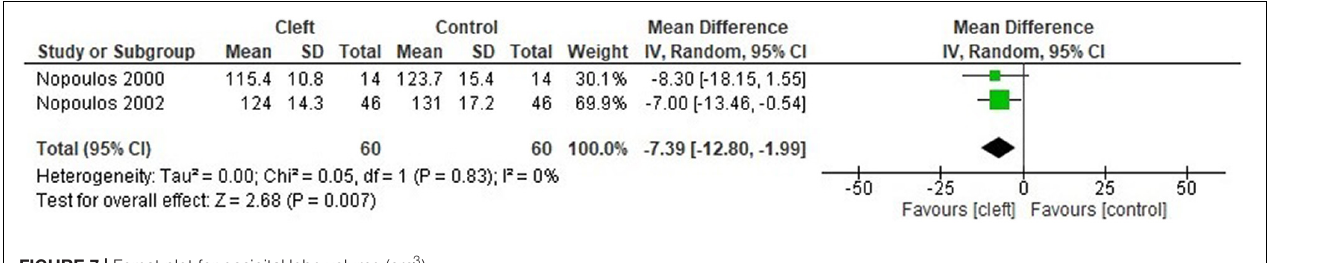
FIGURE 7 | Forest plot for occipital lobe volume (cm 3 ).